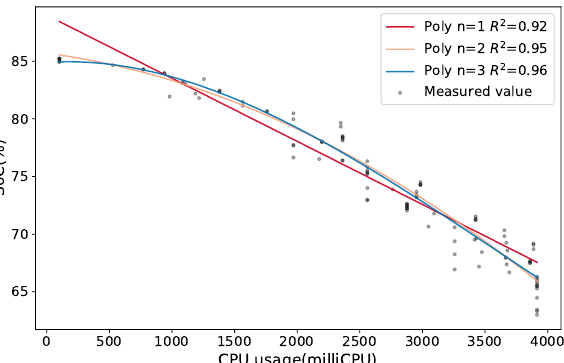
Figure 7. Multiple regression models for the SOC estimation based on CPU usage for a computing